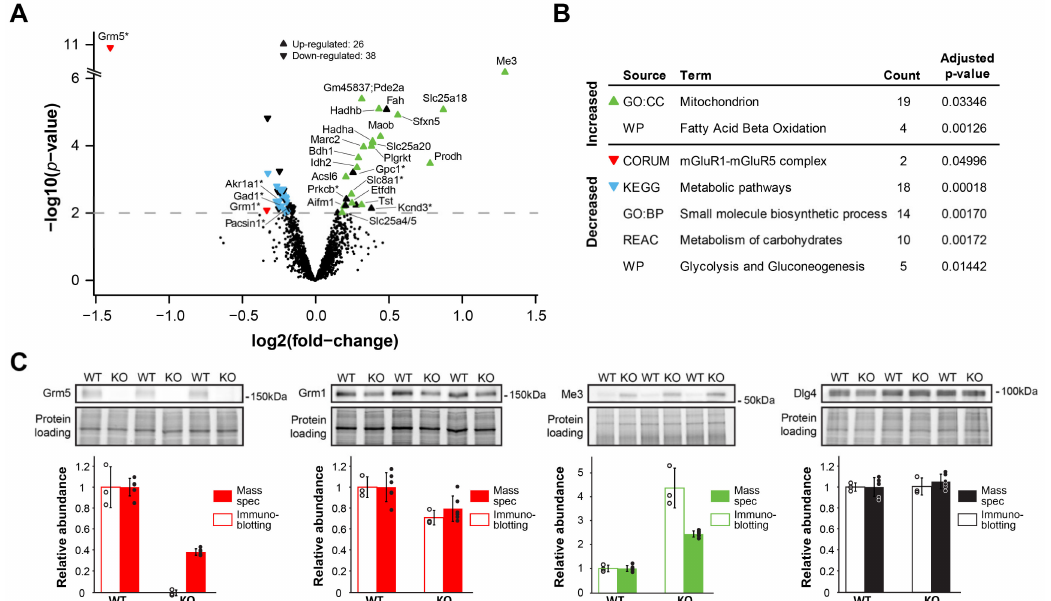
Figure 1. Quantitative proteomics analysis of mGluR5 KO synaptosomes. ( A ) Volcano plot showing the distribution of fold-change protein expression in mGluR5 KO synaptosomes compared to WT mice (N = 6). Proteins above the dotted line were considered significantly regulated (eBayes p < 0.01). Proteins are labeled and colored based on the 3 non-overlapping annotations with highest protein count in ( B ). Asterisks in the protein name tags indicate synaptic proteins based on SynGO. ( B ) Gene ontology enrichment analysis for the significantly regulated proteins ( p < 0.01) depicted in ( A ). The ontology terms with the highest protein count from each database source are indicated. ( C ) SDS-PAGE immunoblot validation of selected proteins found decreased (Grm5, Grm1), increased (Me3), or non-affected (Dlg4) in mGluR5 KO (N = 3). In agreement with the mass spectrometry data, Grm5, Grm1 and Me3 protein expression were found significantly regulated ( t -test p = 0.001, 0.014 and 0.002, respectively), but not Dlg4 ( p = 0.93). Protein loading was visualized and quantified in-gel using 2,2,2-Trichloroethanol to correct total protein amount differences. CORUM, the comprehensive recourse of mammalian protein complexes; GO:BP, Gene Ontology Biological Processes; GO:CC, Gene Ontology Cellular Compartment; KEGG, Kyoto Encyclopedia of Genes and Genomes; REAC, Reactome; WP, WikiPathways Ontology. All bar graphs, means ±